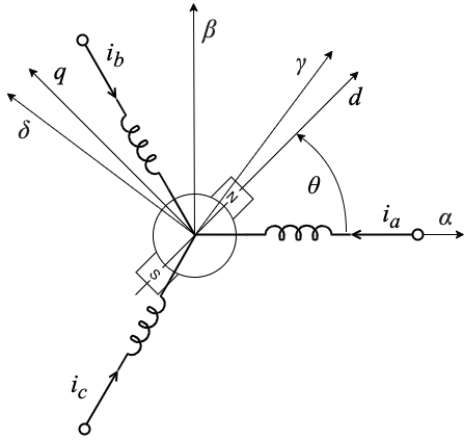
Figure 2. PMSM model in stationary and rotating reference frame.